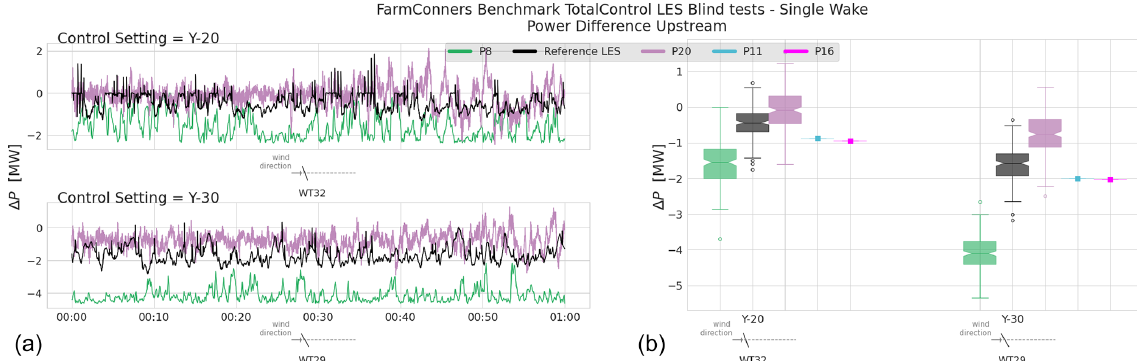
Figure B1. TotalControl LES, single wake under wake steering power difference, (cid:49)P , comparison for the upstream turbines WT32 ( − 20 ◦ yaw) and WT29 ( − 30 ◦ yaw). (a) Time series of (cid:49)P at the upstream turbines illustrated at the submitted frequency by the participants. (b) The distribution of (cid:49)P within the 1h blind test period. For both 20 and 30 ◦ anticlockwise yaw misalignment WFFC scenarios.